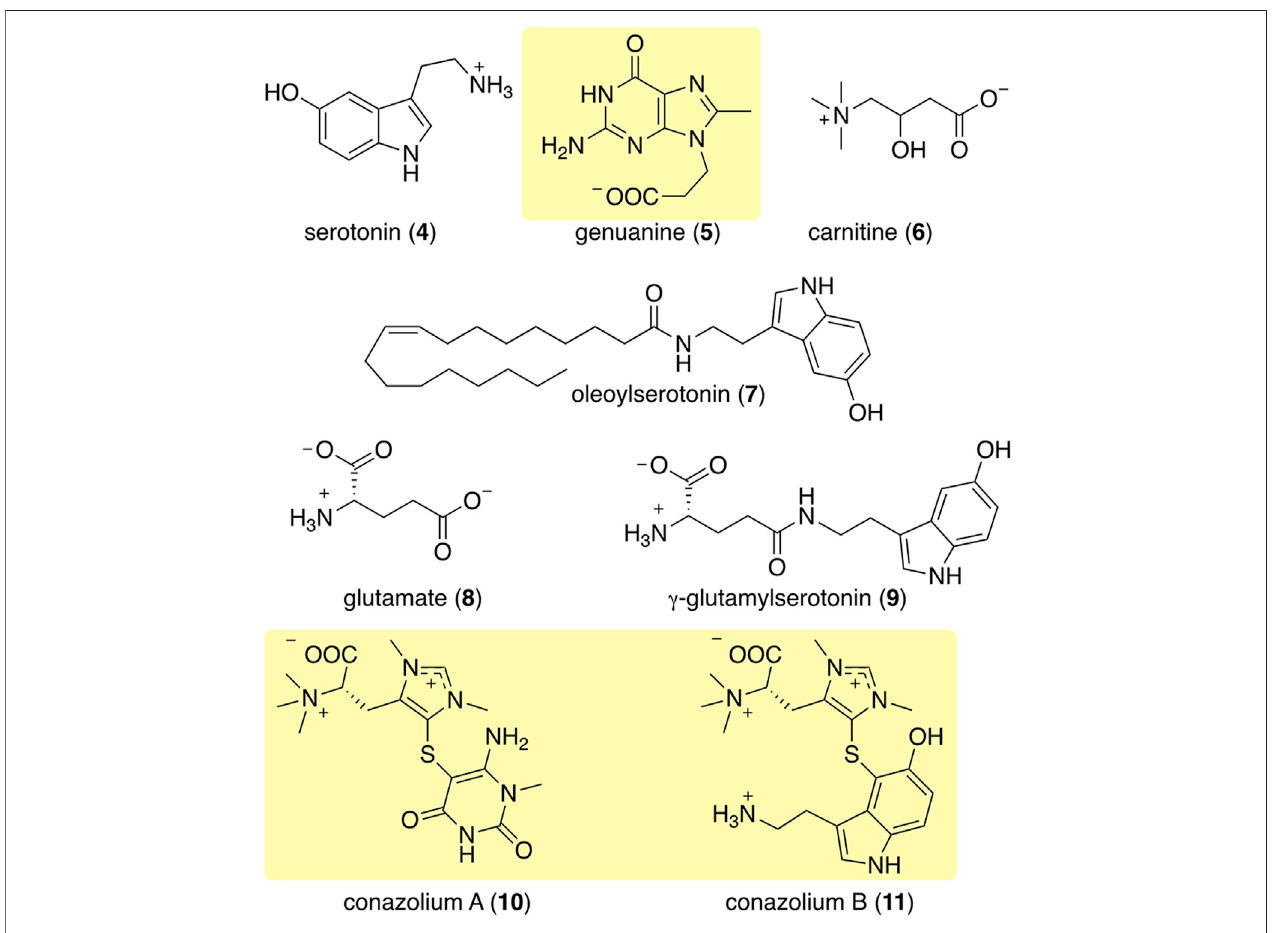
FIGURE 4 | Some of the most abundant compounds discovered in the colored venoms of Stephanoconus snails. Those in shaded yellow are compounds so far found only in Stephanoconus .